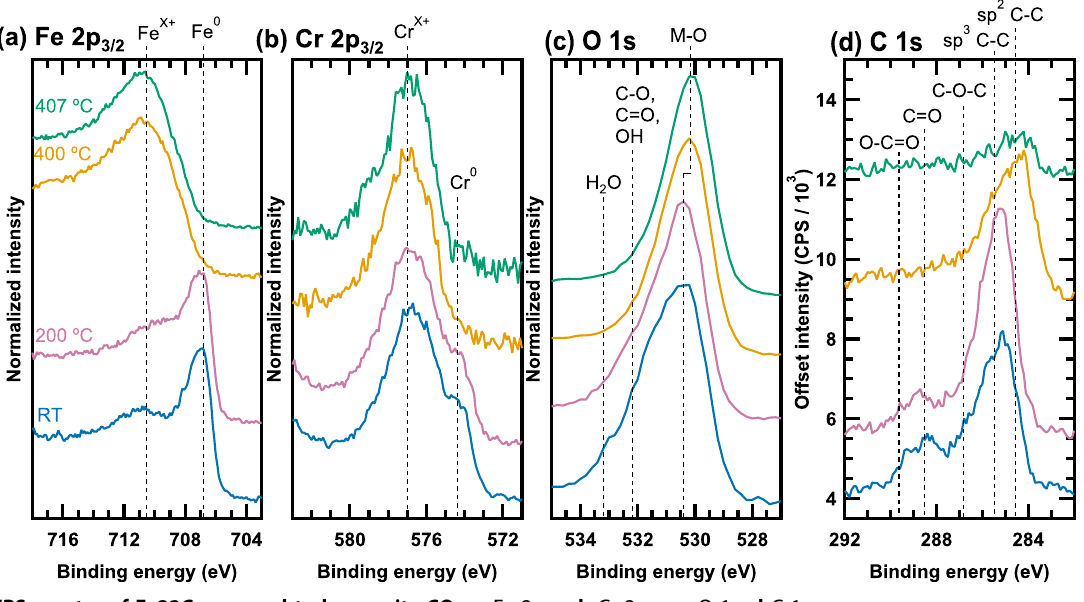
Fig. 3 AP-XPS spectra of Fe22Cr exposed to low purity CO 2 . a Fe 2p 3/2 . b Cr 2p 3/2 . c O 1s. d C